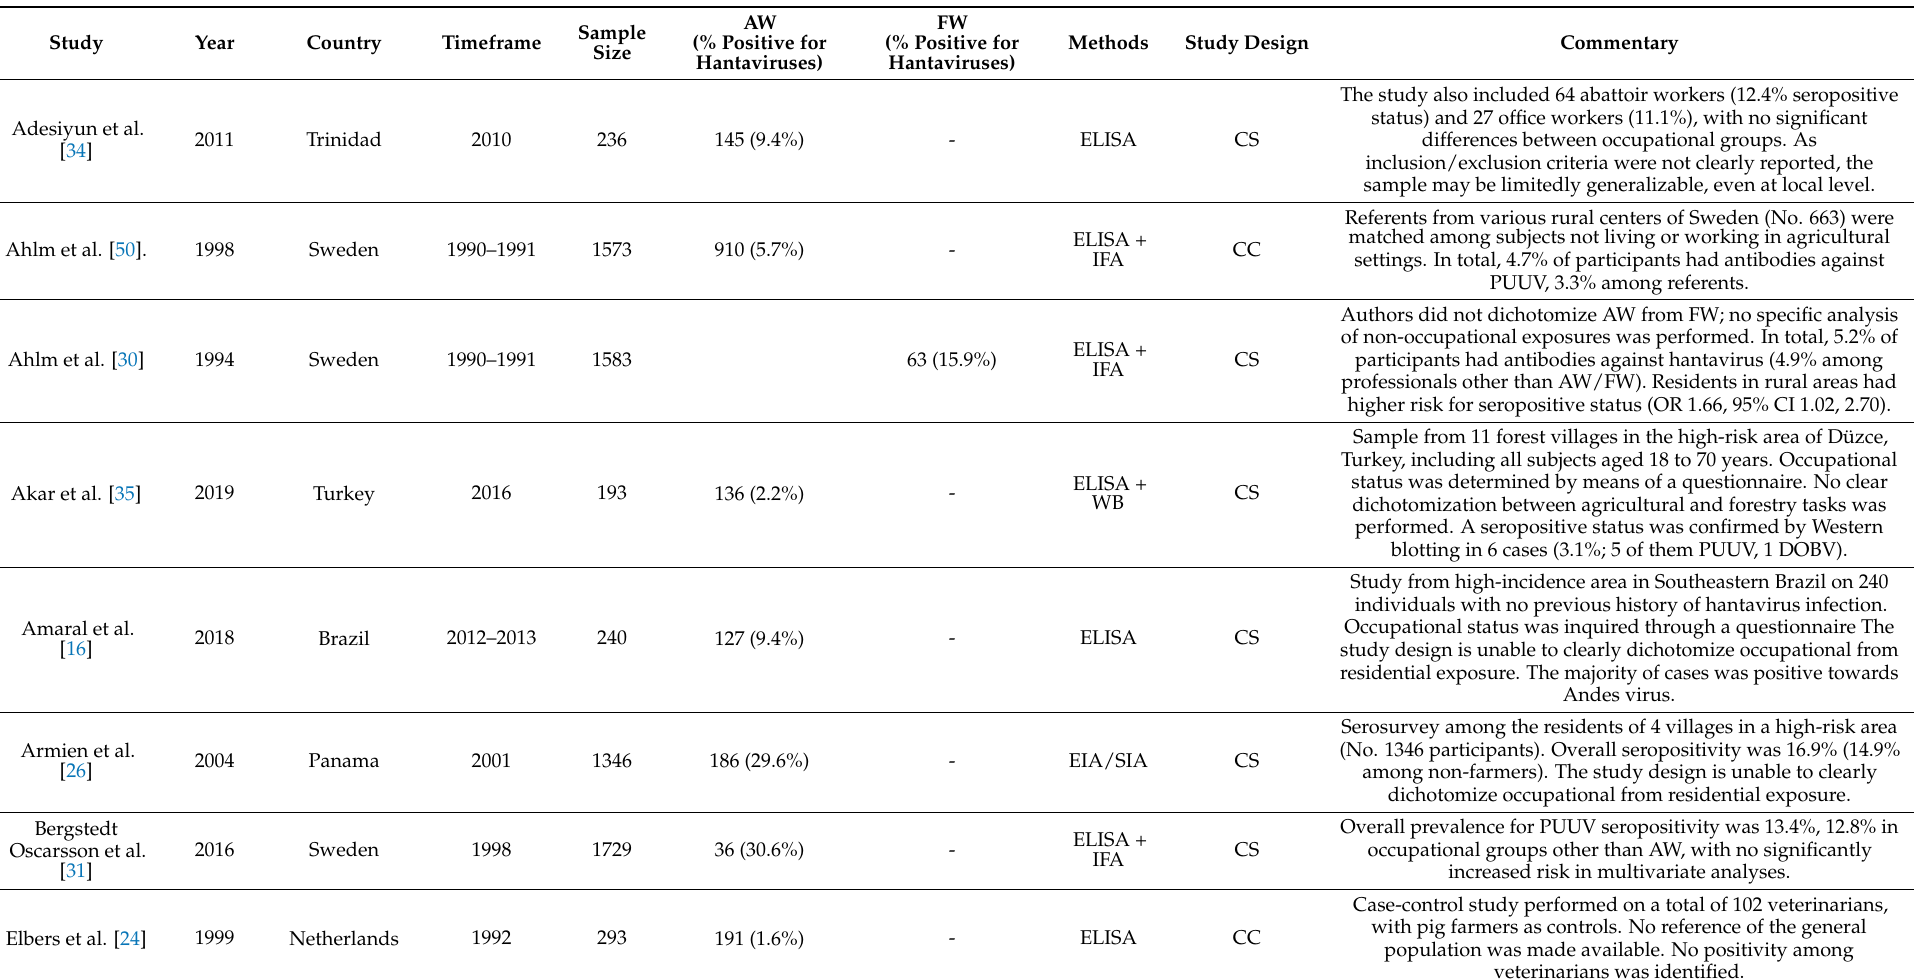
Table 1. Summary of the studies included in the meta-analysis. Notes: CS = cross-sectional; CC = case control; AW = agricultural workers; FW = forestry workers; PUUV = Puumala Virus; DOBV = Dobrava–Belgrade Virus; ELISA = enzyme-linked immunosorbent assay; IFA = immunofluorescent assay; WB = Western blotting; EIA = enzyme immune assay; SIA = strip immunoblot assay; WB = Western blotting/immunoblotting; HTNV = Hantaan virus; SEOV = Seoul